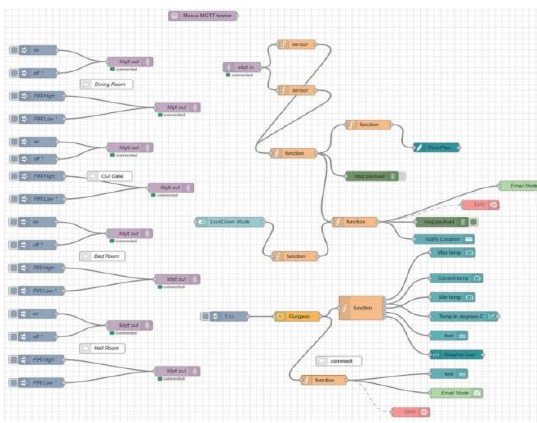
Fig.3. Node red workspace showing all nodes